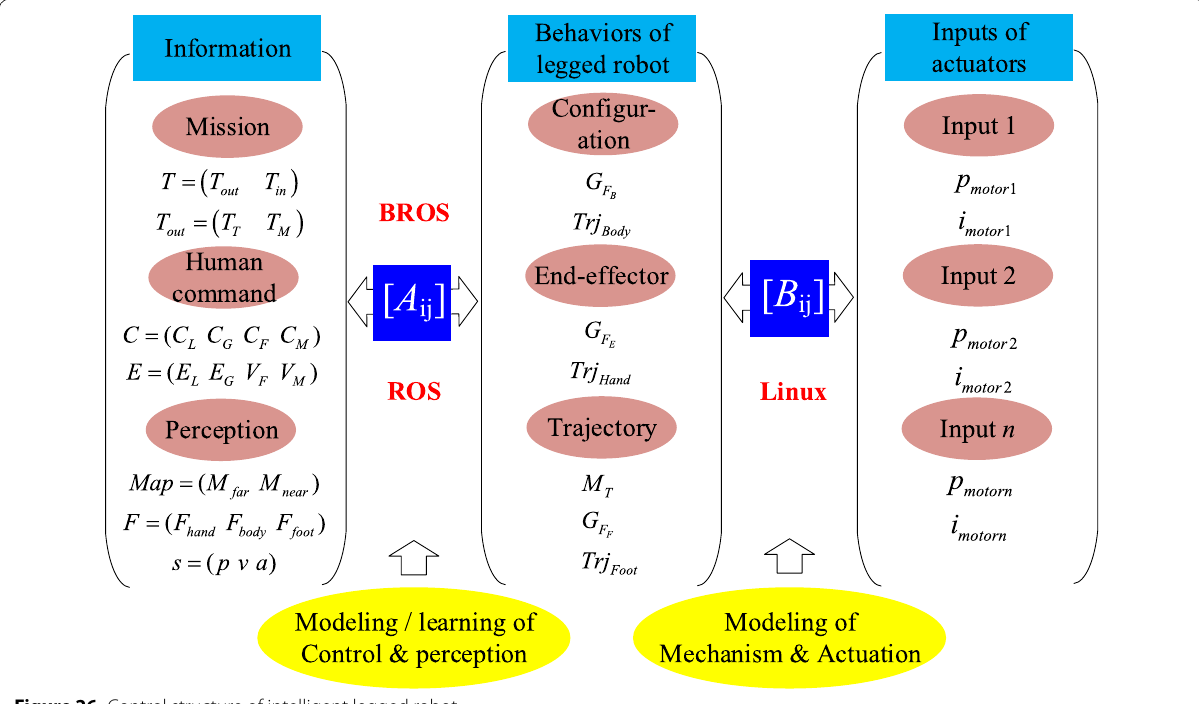
Figure 26 Control structure of intelligent legged